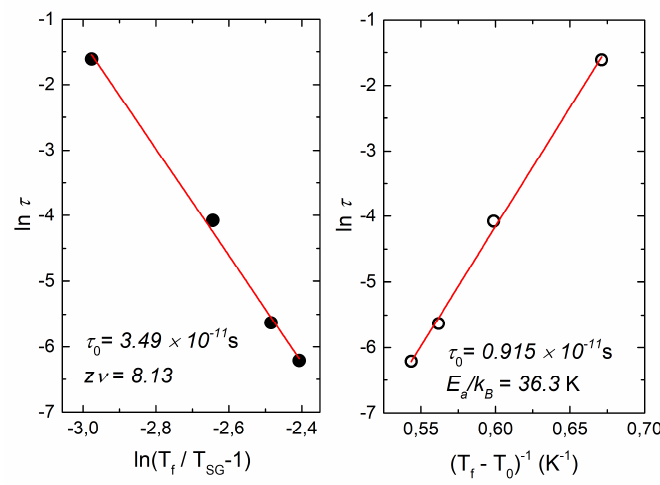
Figure 4. Left ) The fit of the shift of T f to the critical scaling and Right) to the Vogel-Fulcher law. Figure 4. ( Left ) The fit of the shift of T f to the critical scaling and ( Right ) to the Vogel-Fulcher